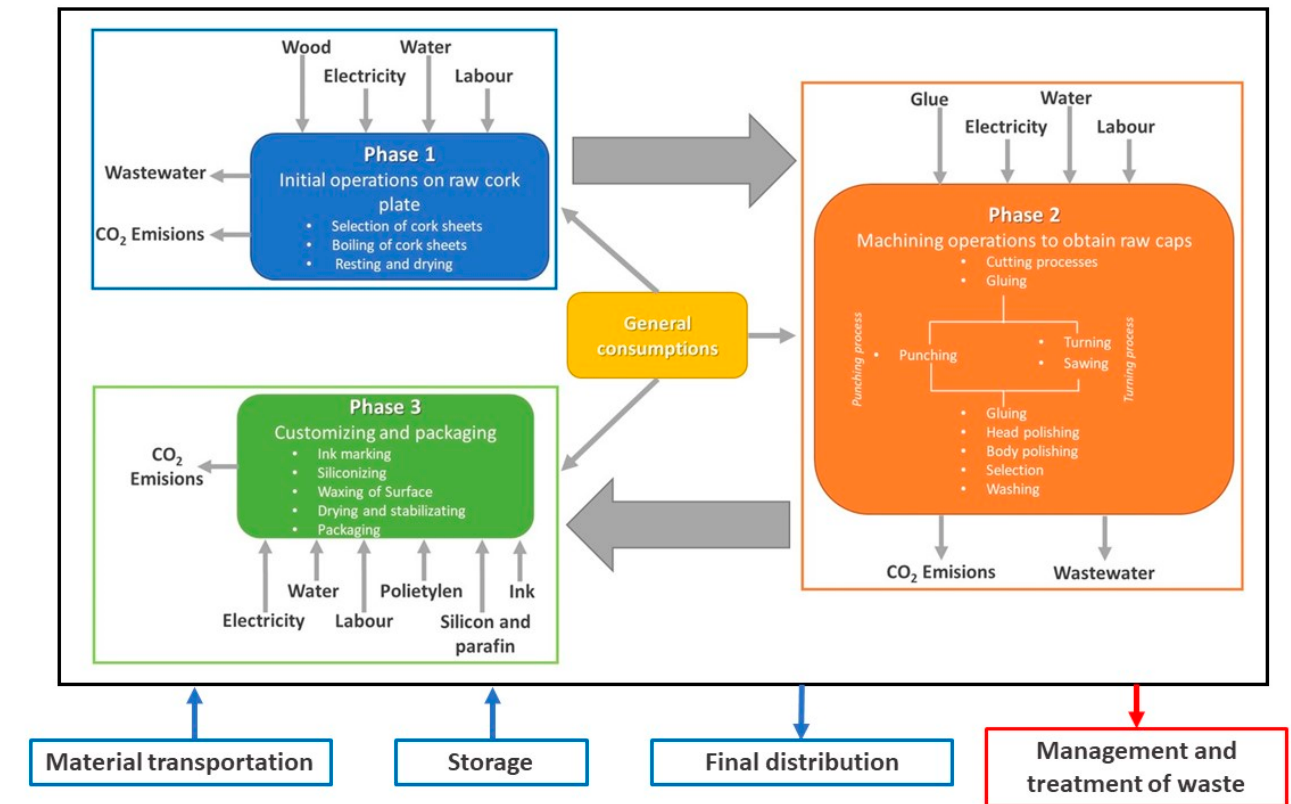
Figure 2. System limits The flowchart displays processes relations and consumption of material, energy, water, and other consumption flows and has been elaborated according to the reality of material, energy, water, and other consumption flows, and these depend on the existing production process [19,20].